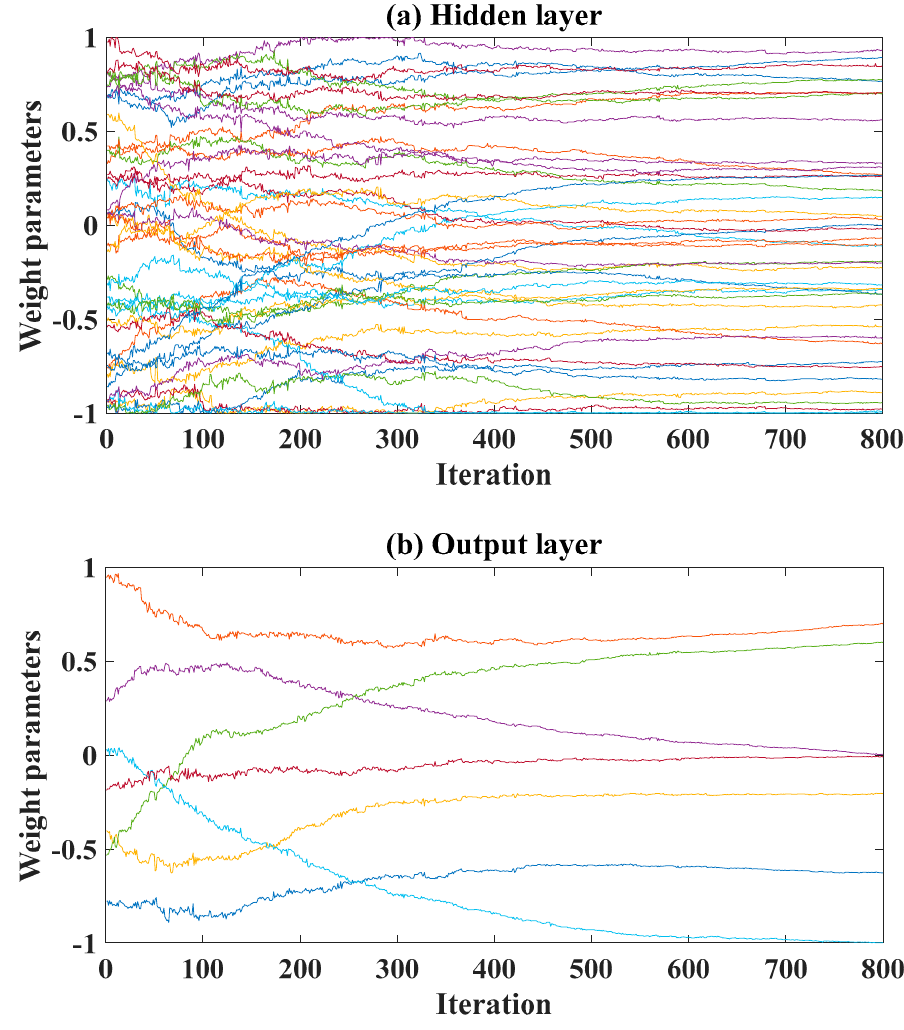
Figure 4. Evolution of weight parameters over 800 iterations: ( a ) weight parameters of input layer (42 parameters); ( b ) weight parameters of hidden layer (7 parameters).